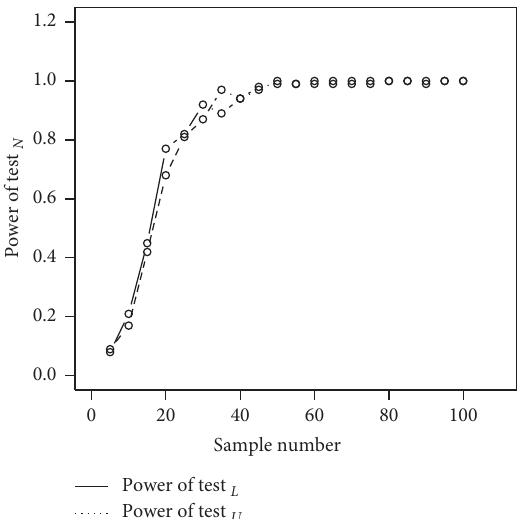
Figure 5: Power curve for the neutrosophic Cauchy distribution.